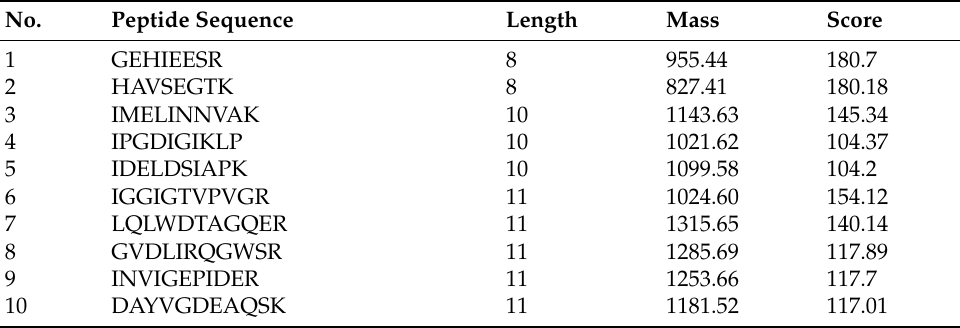
Table 2. The sequence description of the WP-Fe